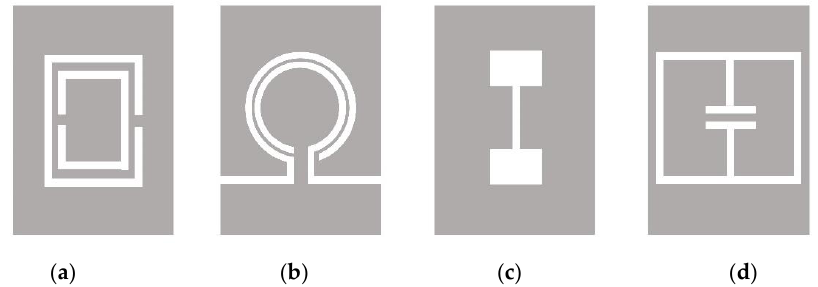
Figure 3. Typical topology of some electrically small slot resonators useful for sensing. ( a ) Complementary split-ring resonator (CSRR), ( b ) open complementary split-ring resonator (OCSRR), ( c ) dumbbell-shaped DGS (DB-DGS), ( d ) magnetic-LC (MLC).